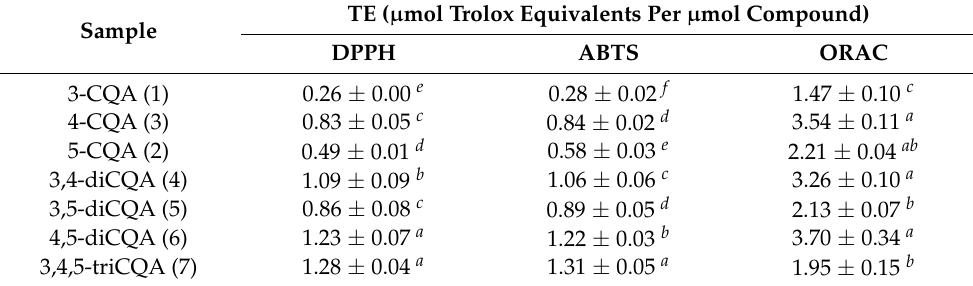
Table 4. Antioxidant activity of the seven target components from the 70% MeOH root extract of V. rigida using DPPH, ABTS, and ORAC